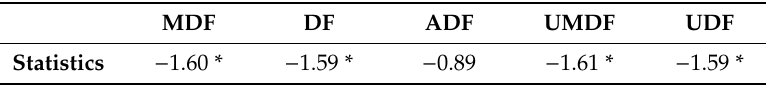
Table 6. Kao cointegration test